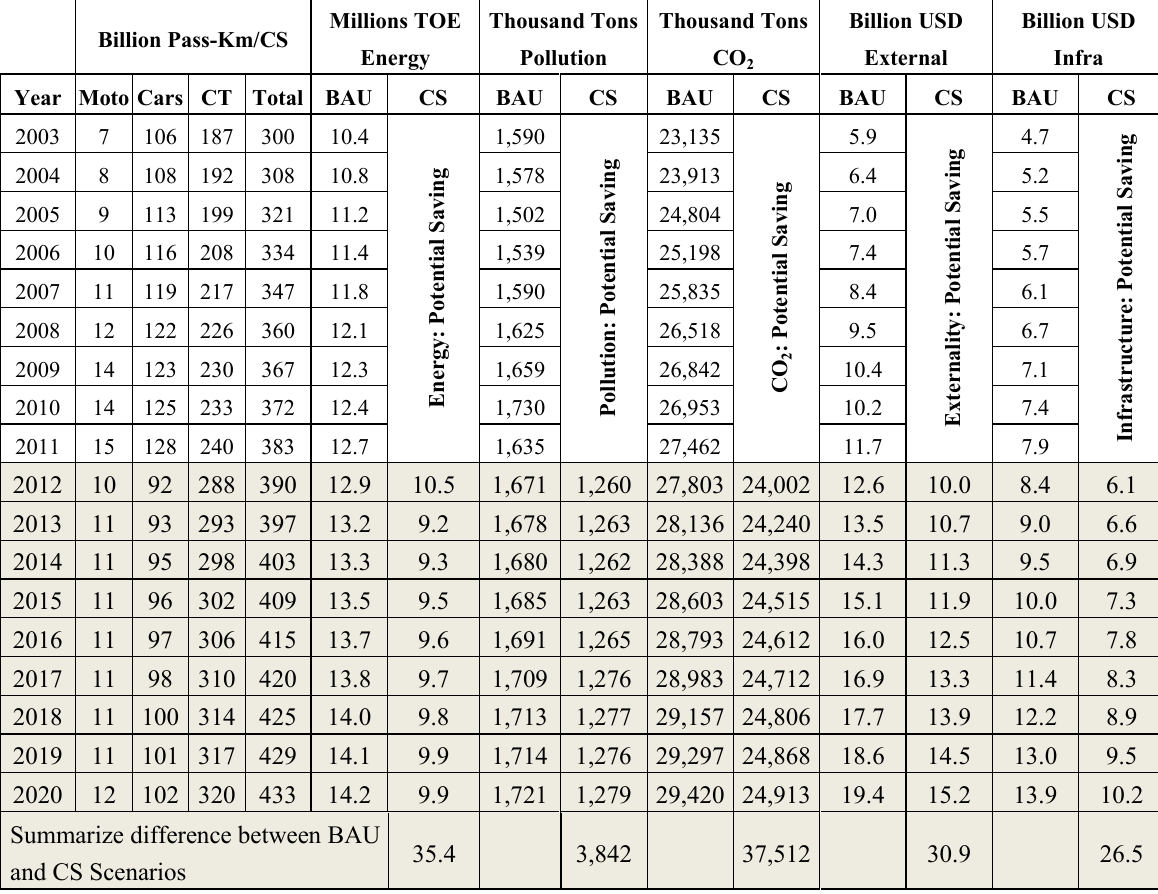
Table 10. Realized and projection of transportation demand, energy, emissions and external costs in a conservationist scenario: